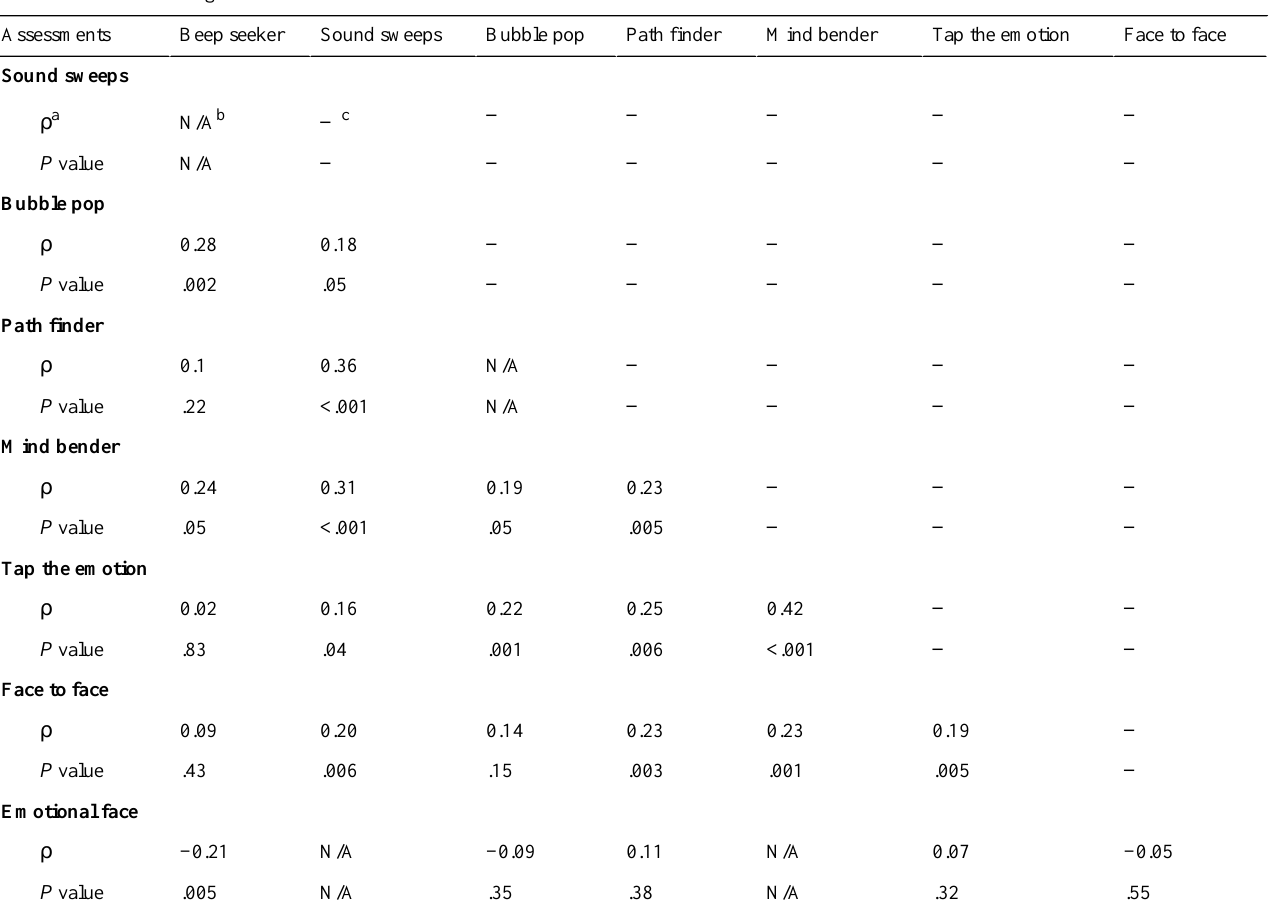
Table 7. Online neurocognitive assessments’correlation